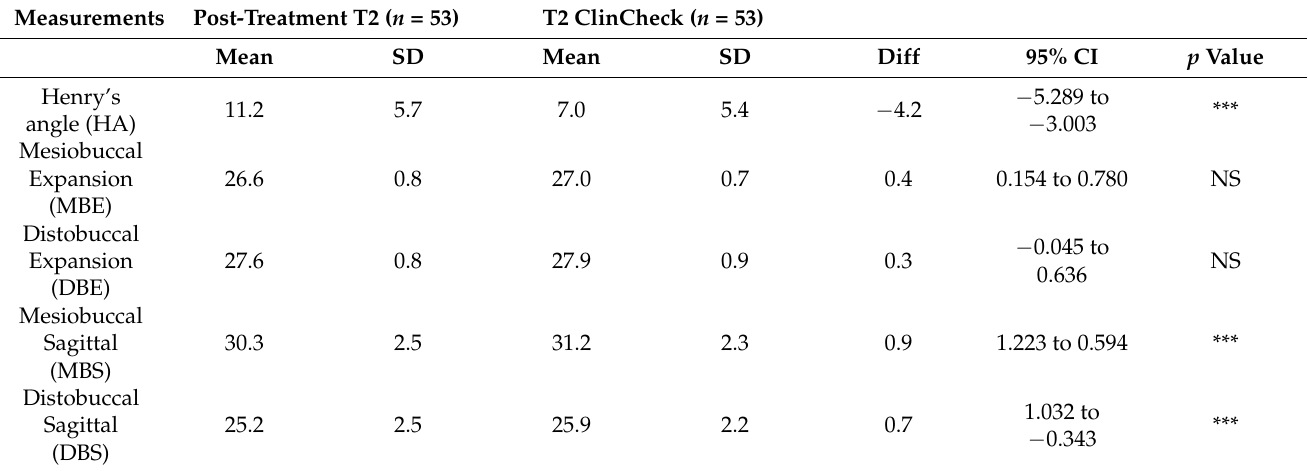
Table 2. Descriptive statistics and statistical comparisons of T2ClinCheck-T2 (Paired t -test).